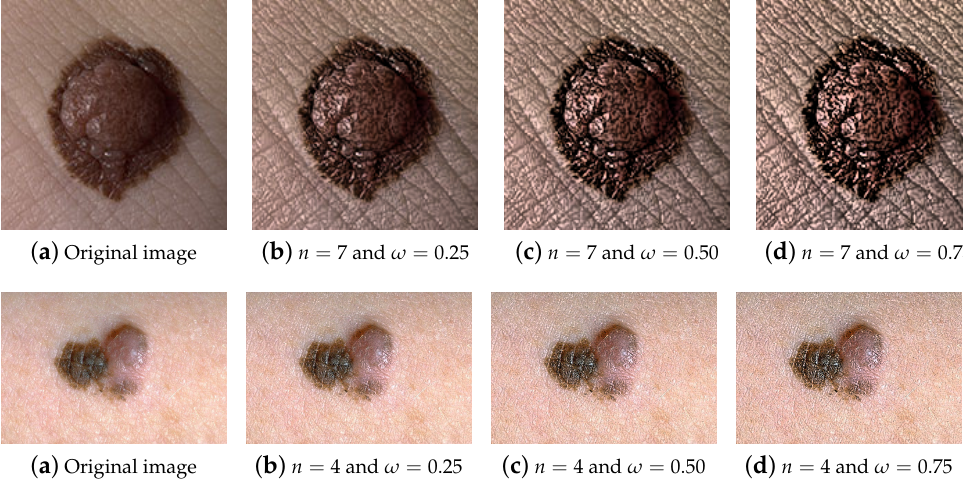
Figure 5. Visual results obtained by MGRTH with different ω